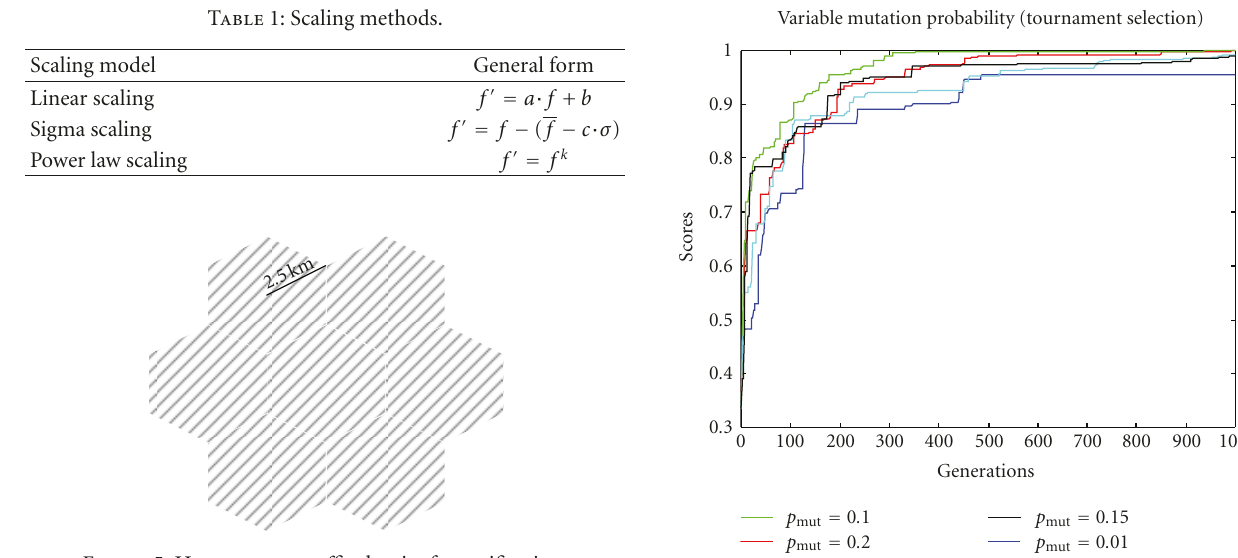
Figure 5: Homogenous tra ffi c density for verification.